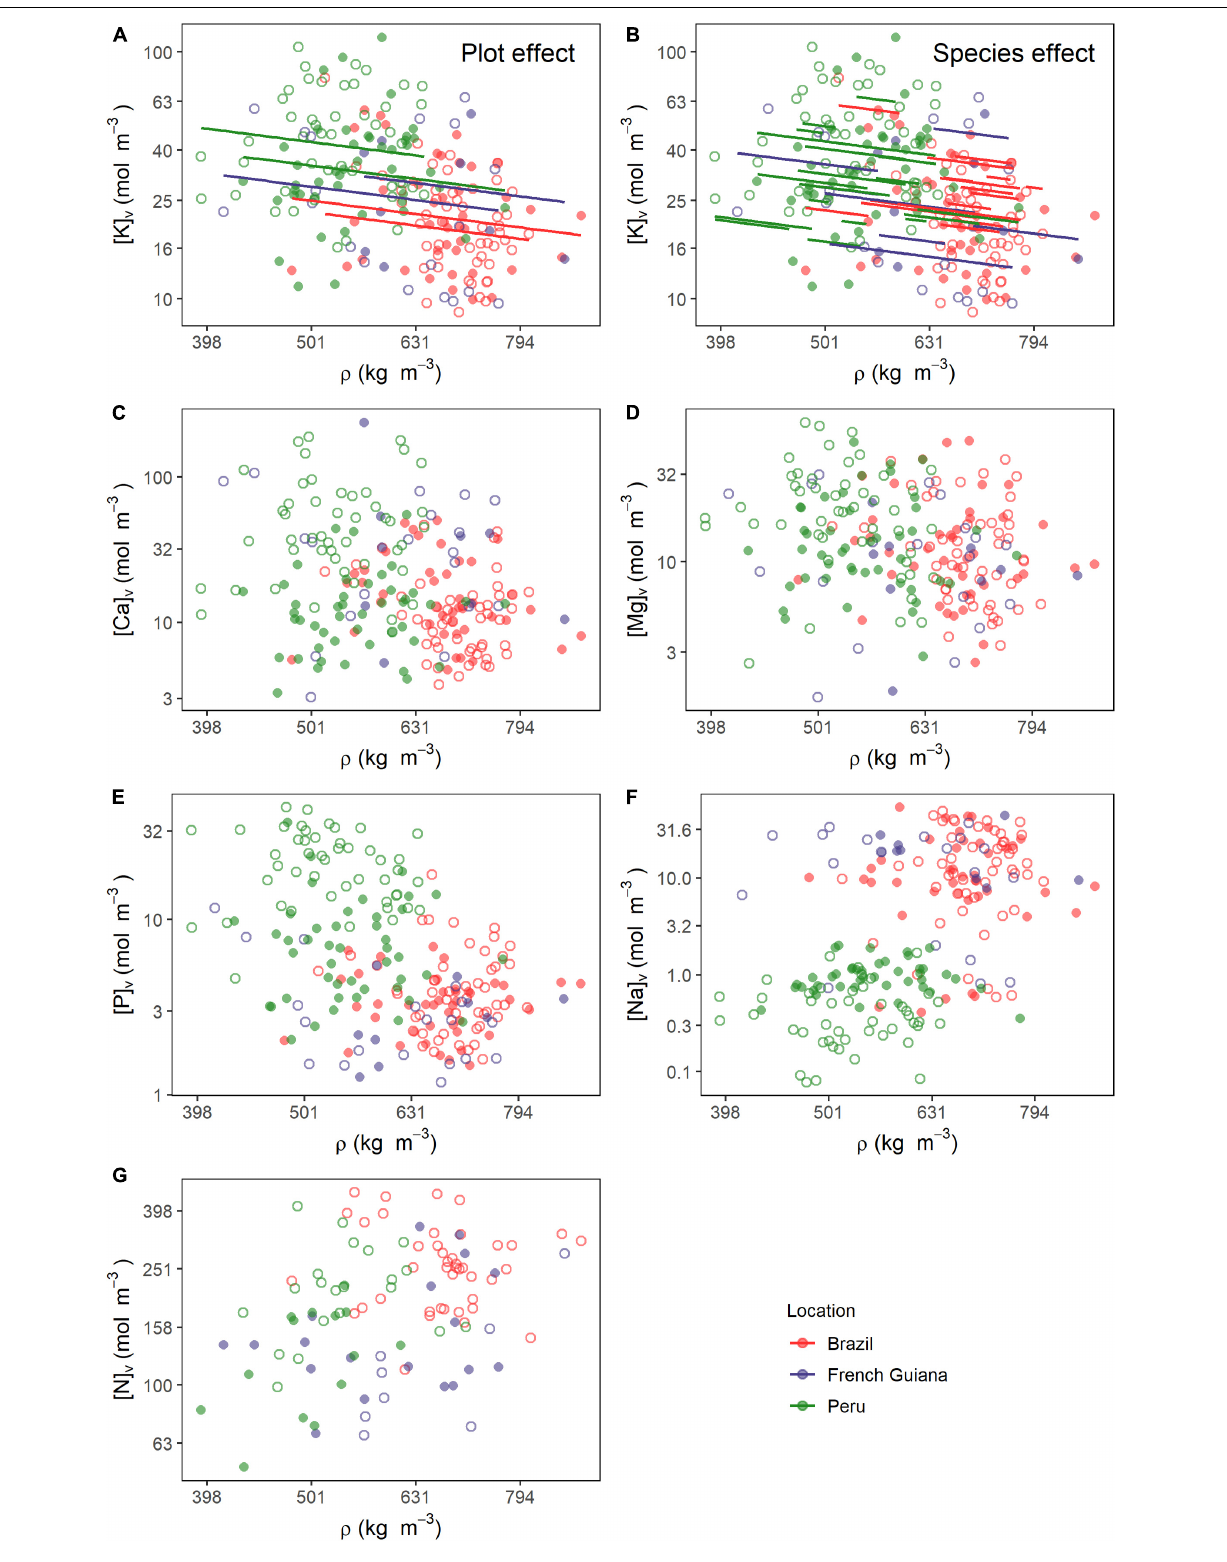
Frontiers in Plant Science |